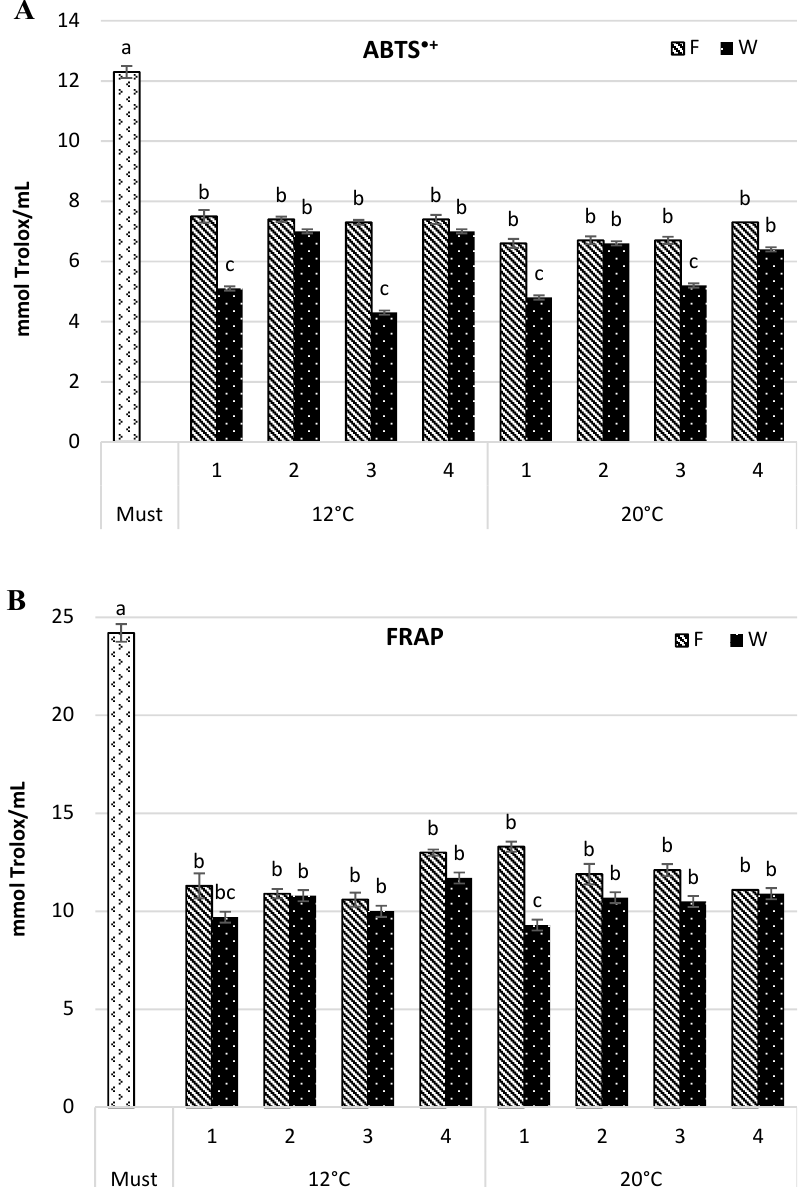
Figure 2. Antioxidant capacity (mmol Trolox/mL) by 2,2 ′ -azinobis-(3-ethylbenzothiazoline-6-sulfonic acid)] radical cation (ABTS • + ) ( A ) and ferric-reducing antioxidant power (FRAP) ( B ) in Aurore must and wine. F—wine after fermentation; W—wine after maturation. Yeast strain: 1—Spontaneous fermentation, 2— S. cerevisiae SIHA ® Cryarome, 3— S. cerevisiae Challenge Aroma White, 4— S. bayanus